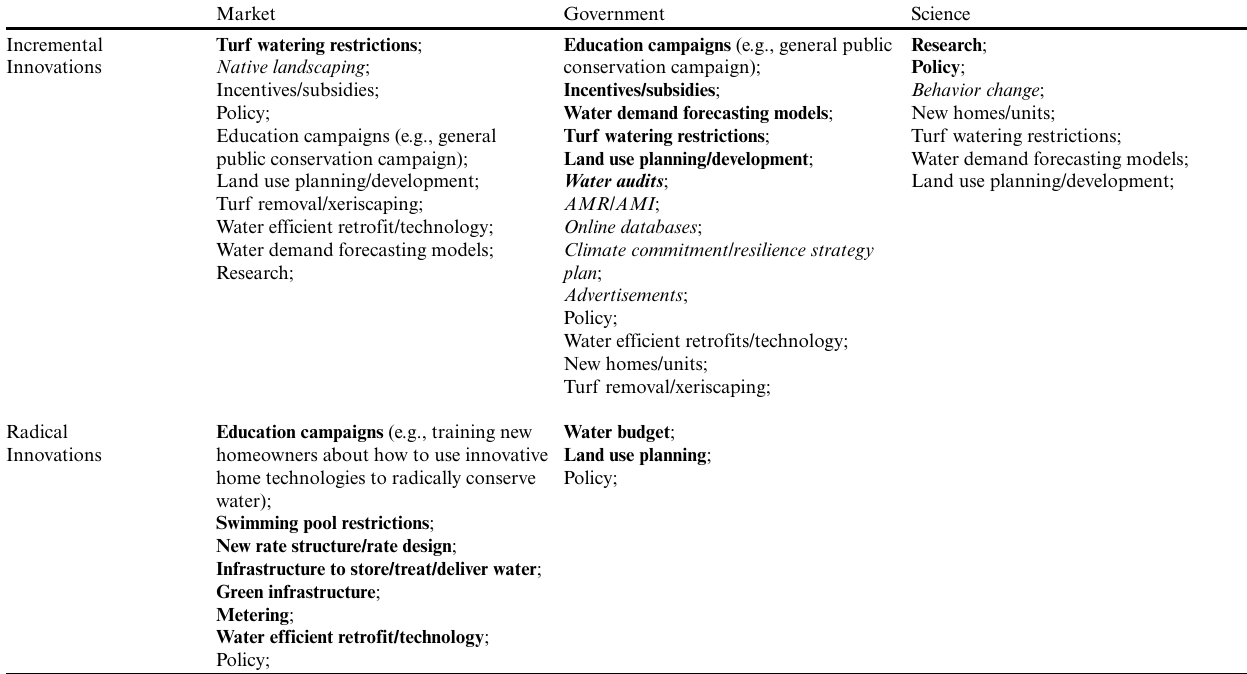
Table 3 . Thematic categorization of incremental and radical innovations, by stakeholder sector. Bolded innovations were most salient among stakeholders in each sector. Italicized innovations were unique to stakeholders in each sector. AMR/AMI, Automatic Meter Reading/Advanced Metering